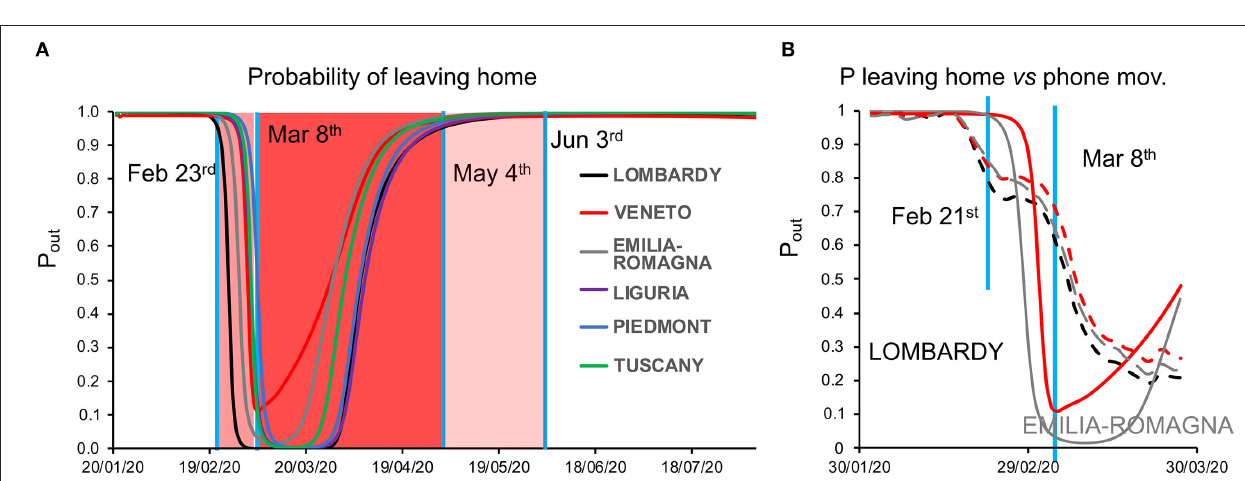
the first weeks of the epidemic peaking with different values in each region, with Veneto and Lombardy at the bottom and top of the range, respectively ( Figure 3B ). Of note,